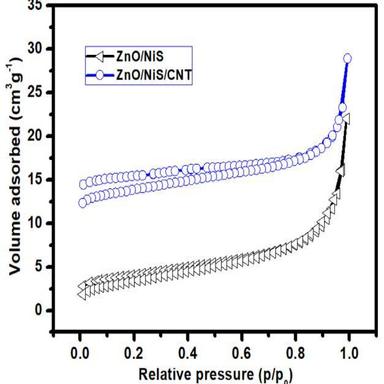
The Brunauer–Emmett–Teller (BET) surface area obtained from nitrogen adsorption-desorption isotherms.